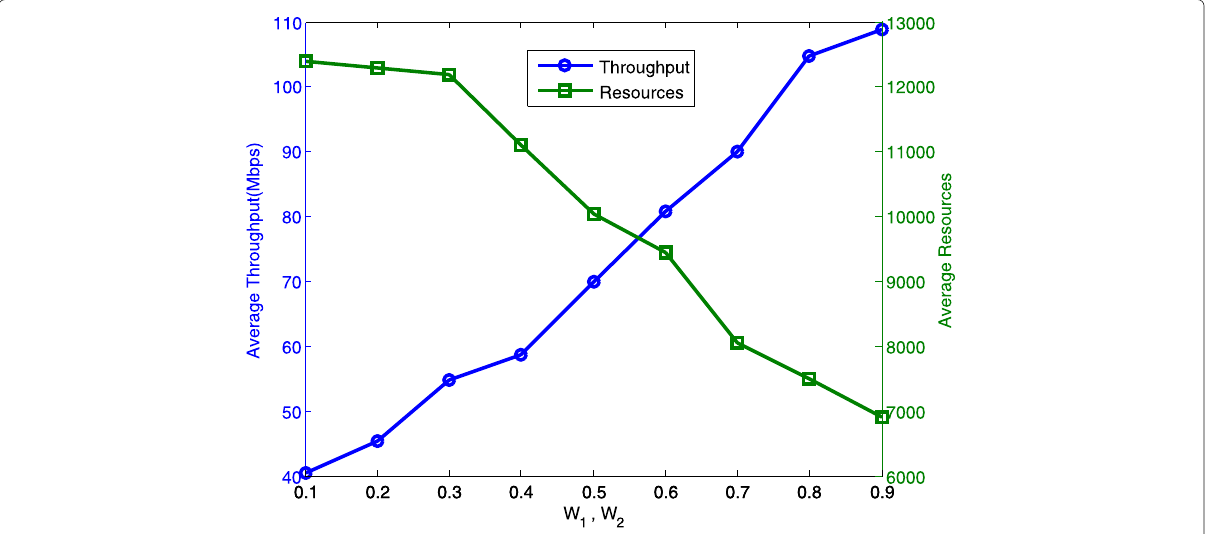
Fig. 6 Average throughput and resources for varying